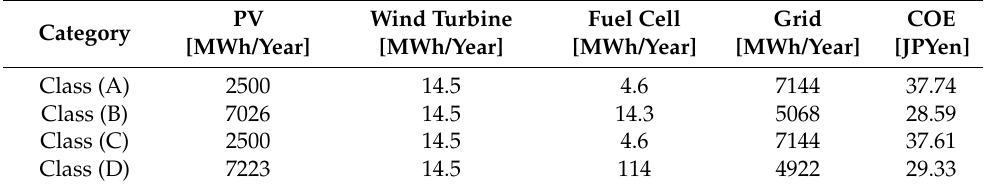
Table 15. Electricity generation from each component of the HRES in the future cost scenario. Category